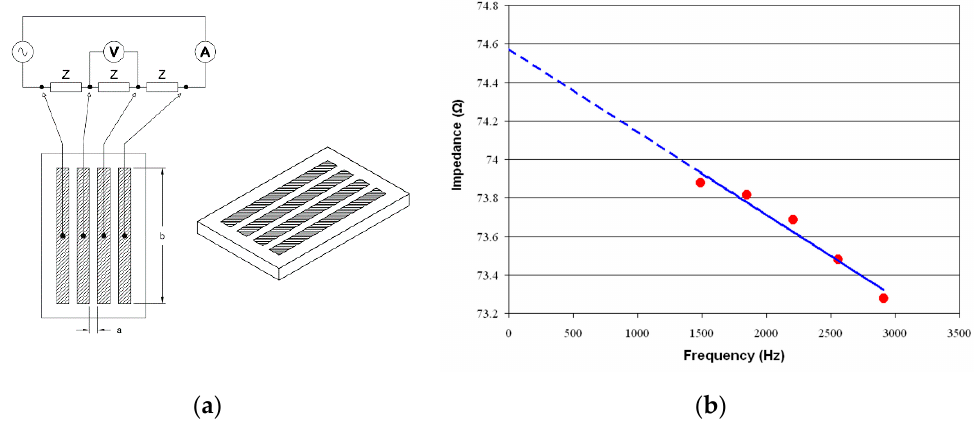
Figure 8. Conductivity measurement. ( a ) The conductivity sensor equivalent circuit, and ( b ) the impedance in multiple frequencies was measured and the resistance calculated using linear regression.